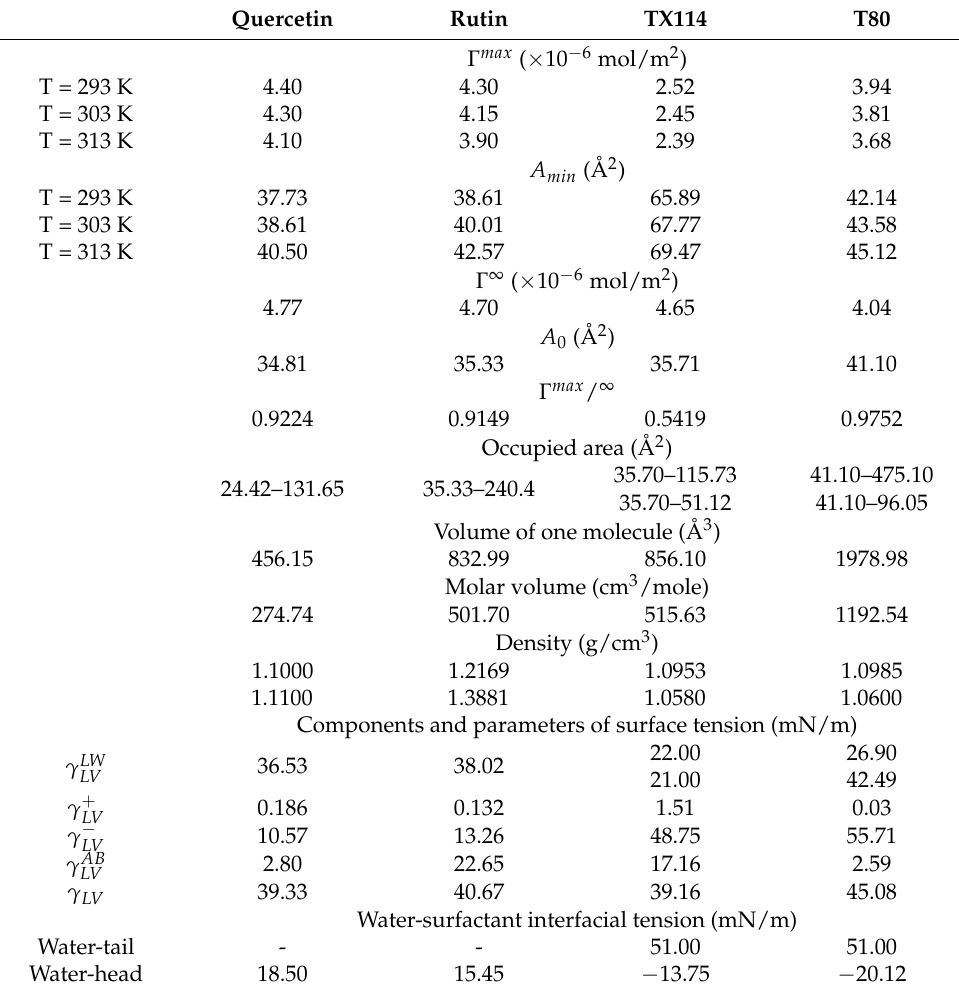
Table 1. The thermodynamic parameters for quercetin, rutin, TX114 and T80. Quercetin Rutin